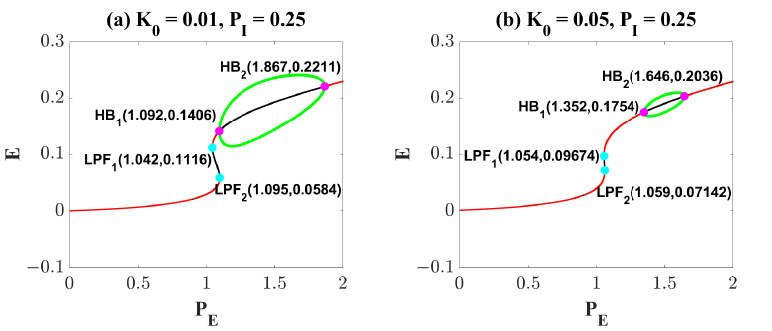
Figure 6. Time series diagram under the influence of electromagnetic induction. ( a ) I mf is ineffective, i.e., the amplitude of the oscillatory state hardly changes. As K 0 increases, amplitude of the oscillatory state decreases ( b ) and eventually becomes the high-level ( c ) and the medium-level equilibrium point states ( d ). I mf and arrows indicate that the electromagnetic induction model and Wilson–Cowan model are coupled at t = 200